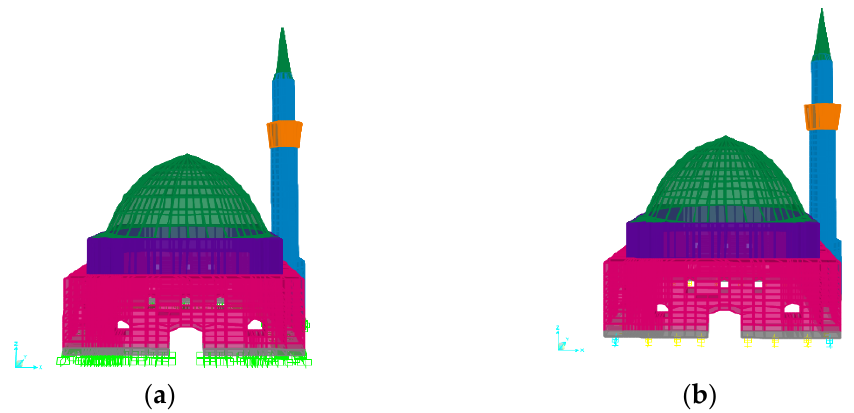
Figure 2. Finite element model of the mosque. ( a ) Fixed Base. ( b ) Base Isolated.